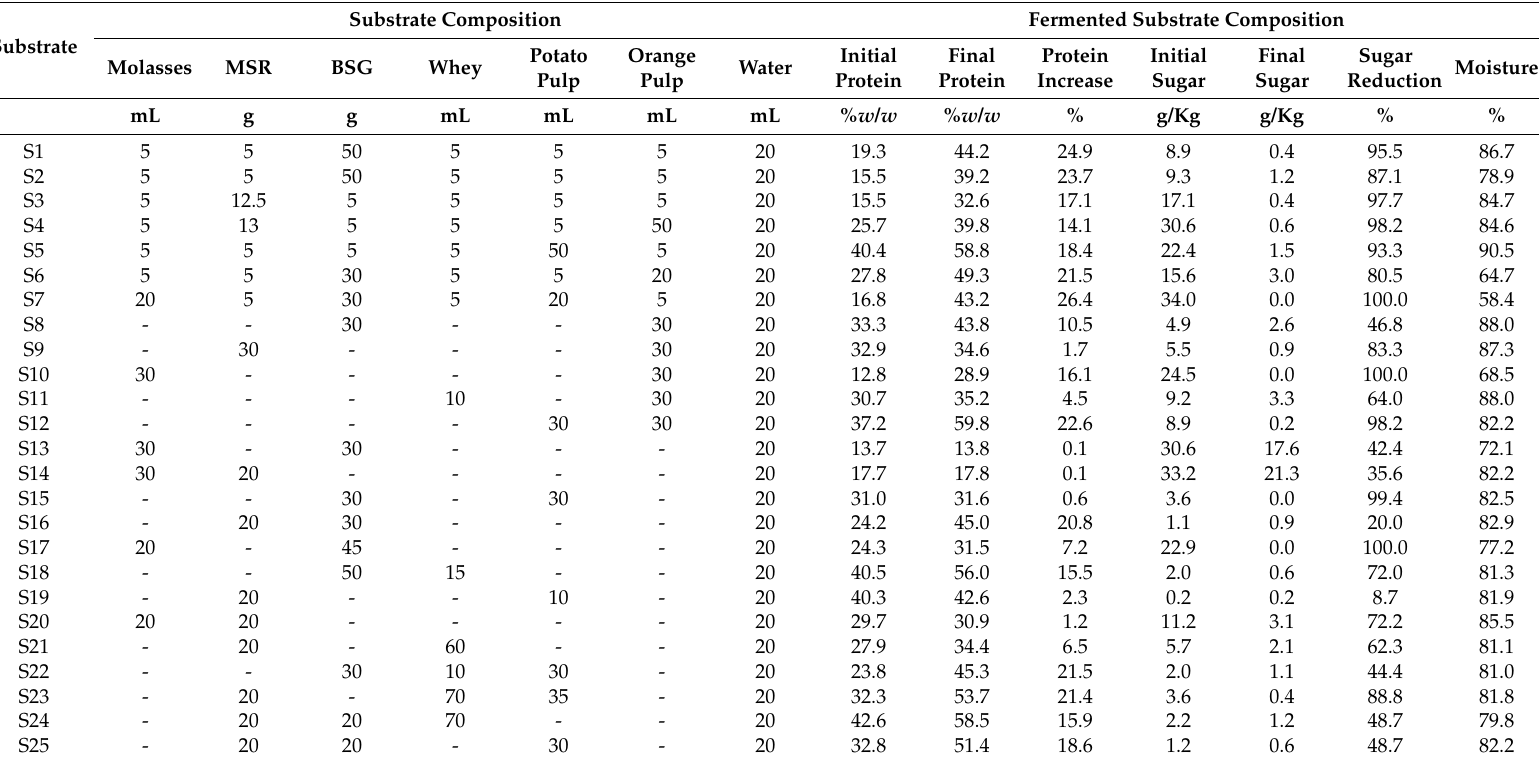
Table 1. Composition of the mixed agroindustrial side-streams and wastes (AISS) substrates before and after solid-state fermentation (SSF) by P. ostreatus at 25 ◦